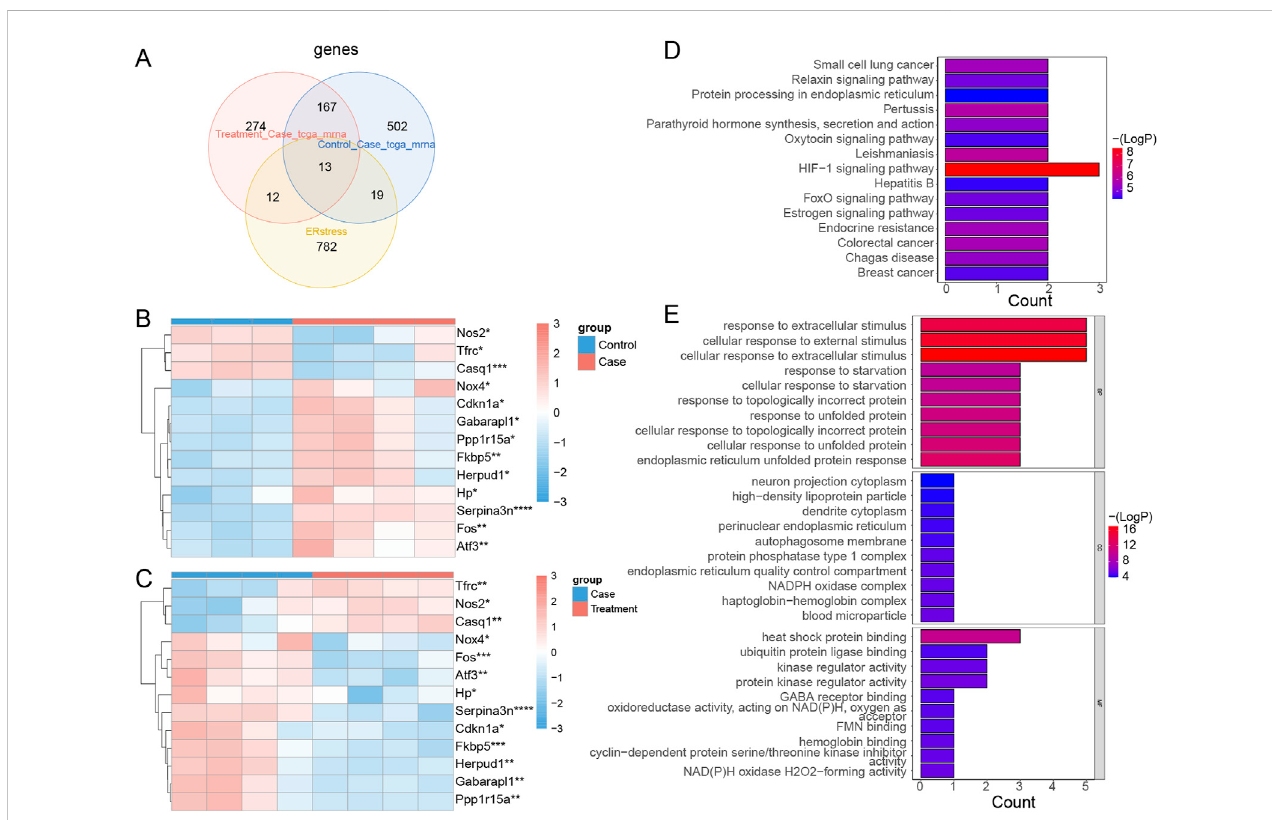
FIGURE 5 Identi fi cation of DE-ERSRGs and functional enrichement analysis. (A) Venn diagram of 13 DE-ERSRGs by overlapping DEGs in control vs. case group, DEGs incasegroup vs.treatment, with826 ERstress-related genes. (B) Heatmapofexpressionof13 DE-ERSRGsincontrol andcase groups. (C) Heatmapof expression of 13 DE-ERSRGs in the case and treatment groups. (D) KEGG pathway analysis of 13 DE-ERSRGs. (E) GO enrichment analysis of 13